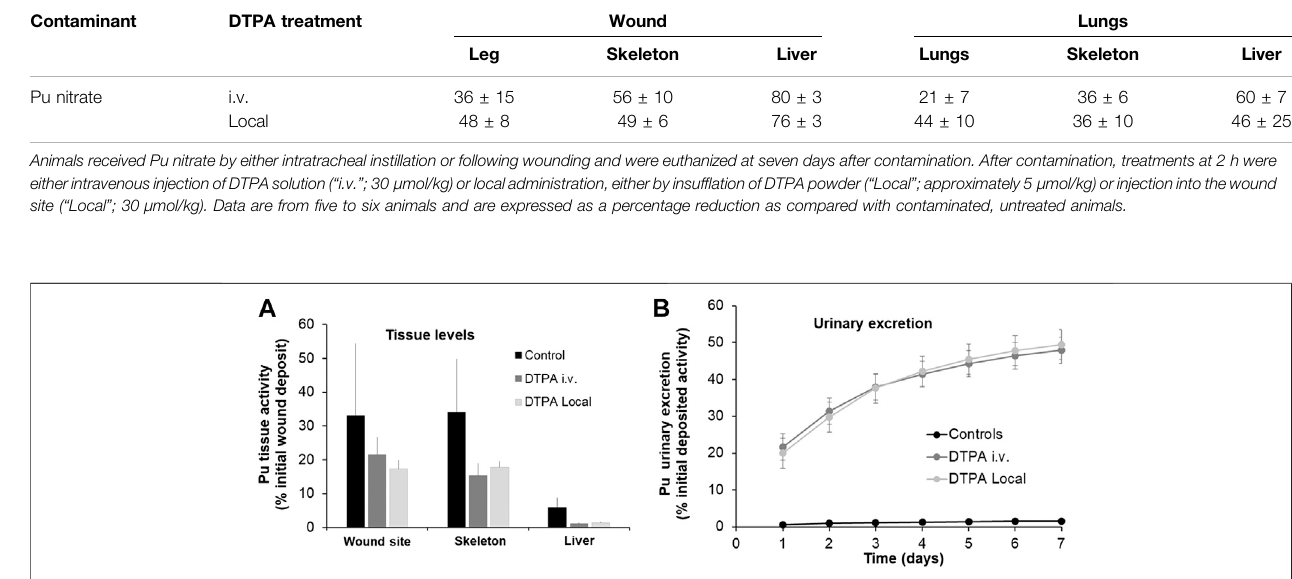
FIGURE 2 | Effect of single systemic or local DTPA administration on tissue (A) and urine (B) activity levels following wound contamination with Pu nitrate. Animals werecontaminatedfollowinganincisional woundwithPunitrate(6 kBq) andwereeuthanized atsevendaysafter contamination.Urineswerecollected over